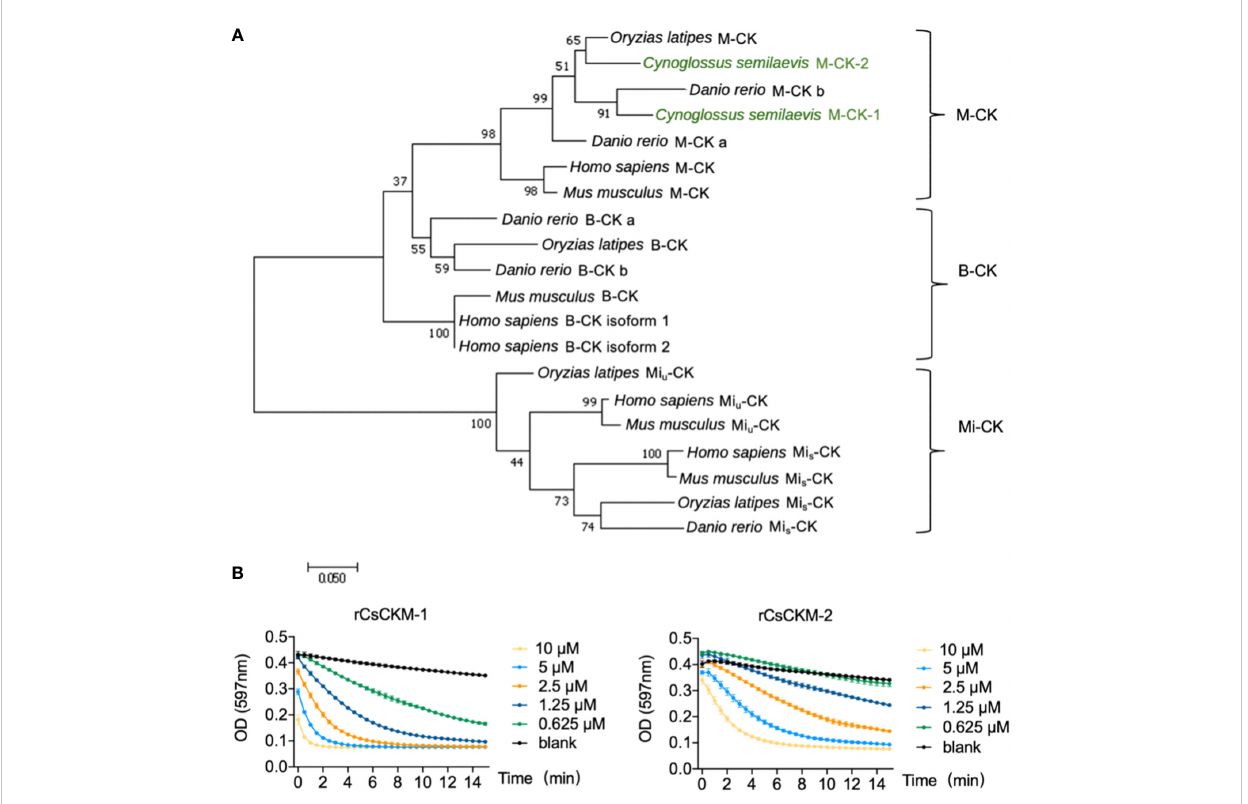
FIGURE 1 Phylogenetic and activity analyses of CsCKM-1/2. (A) Phylogenetic analysis of CK homologs. The numbers indicate bootstrap values based on 1500 replications. M-CK, muscle type CK; B-CK, brain type CK; Mi-CK, mitochondrial type CK; Mi u -CK, ubiquitous type Mi-CK; Mi s -CK, sarcomeric type Mi-CK. (B) rCsCKM-1/2 at different concentrations were incubated with the substrates. The enzymatic reaction was recorded every 30 seconds by monitoring the absorbance of thymol blue (pH indicator) at 597 nm, because creatine kinase catalysis generates hydrogen